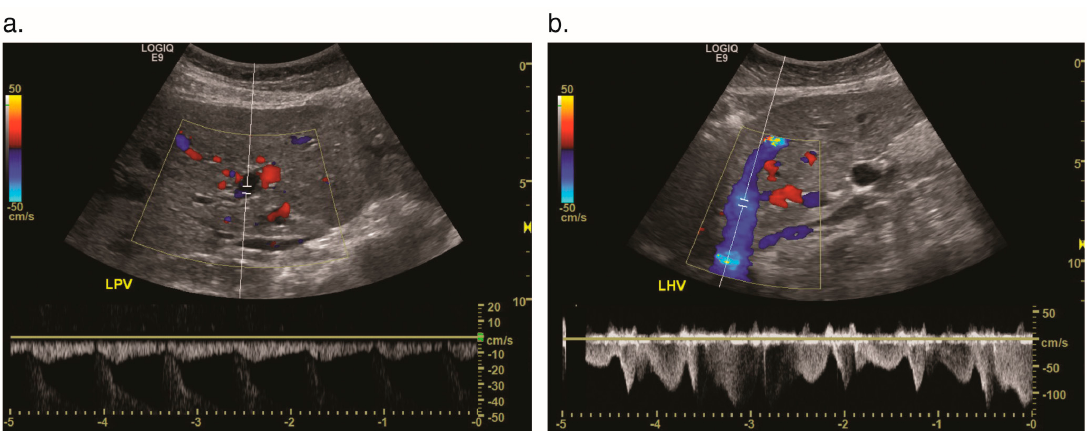
Figure 4. Hepatic vascular malformations on spectral Doppler ultrasound (US) in a 69-year-old woman with HHT. ( a ) Evaluation of the left portal vein shows reversed, pulsatile flow due to arterioportal shunting. (LPV = left portal vein). ( b ) Evaluation of the left hepatic vein shows arterialized waveforms due to artery to hepatic vein (arteriosystemic) shunting. (LHV = left hepatic vein).